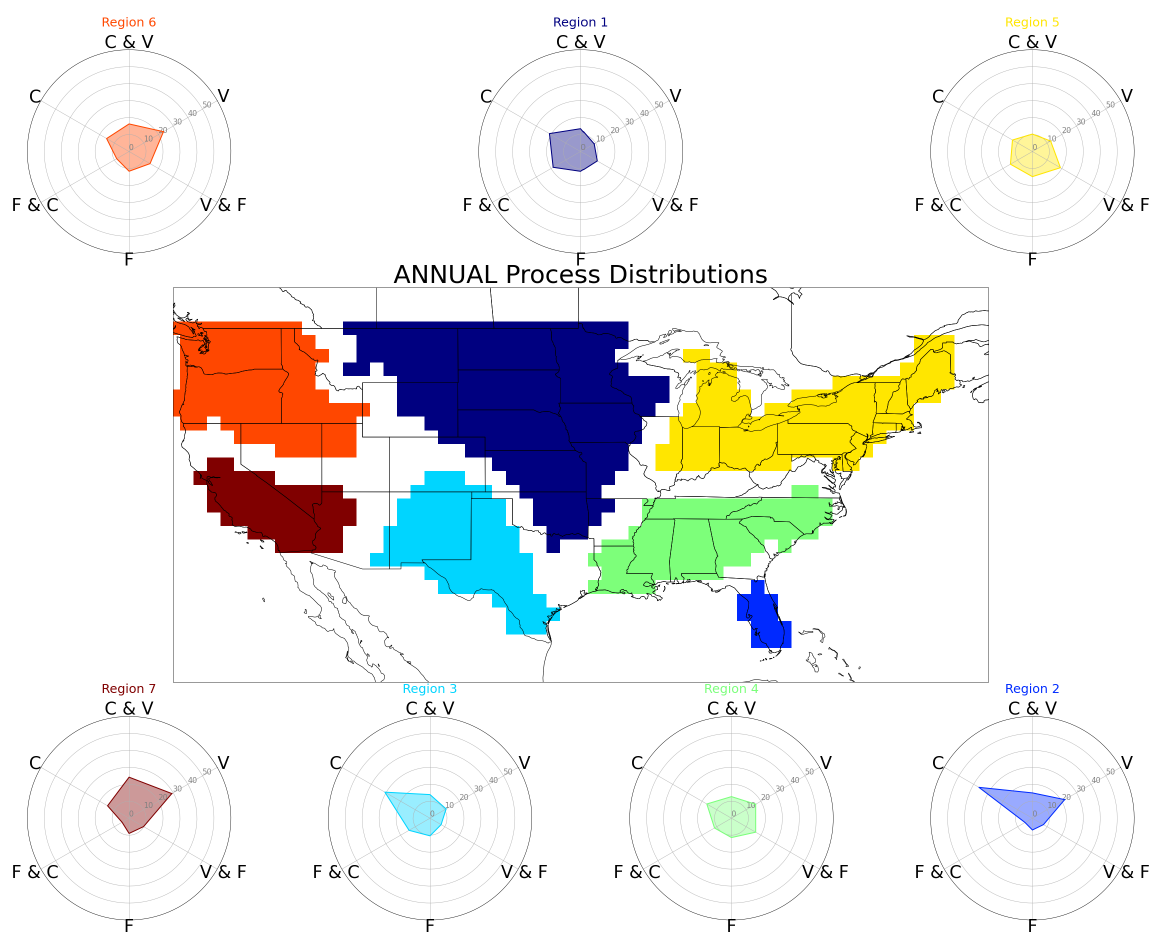
Figure 7. Central plot shows the regions over which extreme precipitation was aggregated. The distributions of the various categories for extreme precipitation within each region are shown around this central plot. Concentric rings are in increments of 10%. This includes every event in the record used, except those in the “ALL” and “None” categories. Those events were omitted to aid the visualization. “None” type events make up no more than 4% of the events of any combination of region and